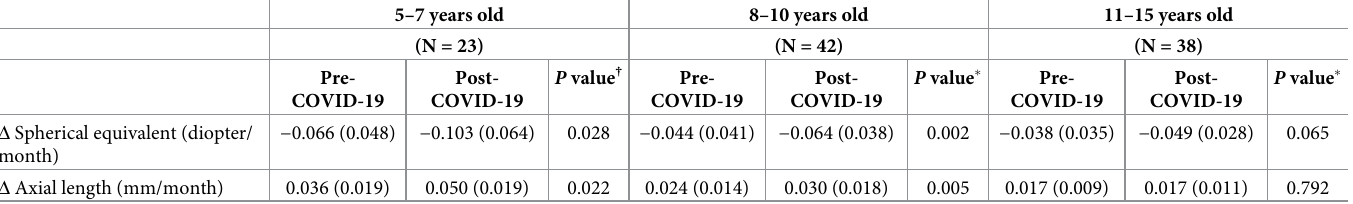
Table 3. Comparisons of the changes of refractive error and axial length between pre- and post-coronavirus disease 2019 in 5–7, 8–10, and 11–15 years old